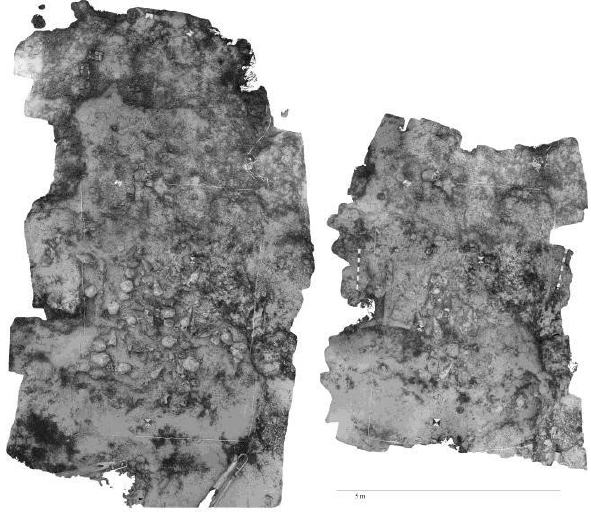
Figure 10. Orthophotos of the layer 1 and layer 2 of the shipwreck, 2015.